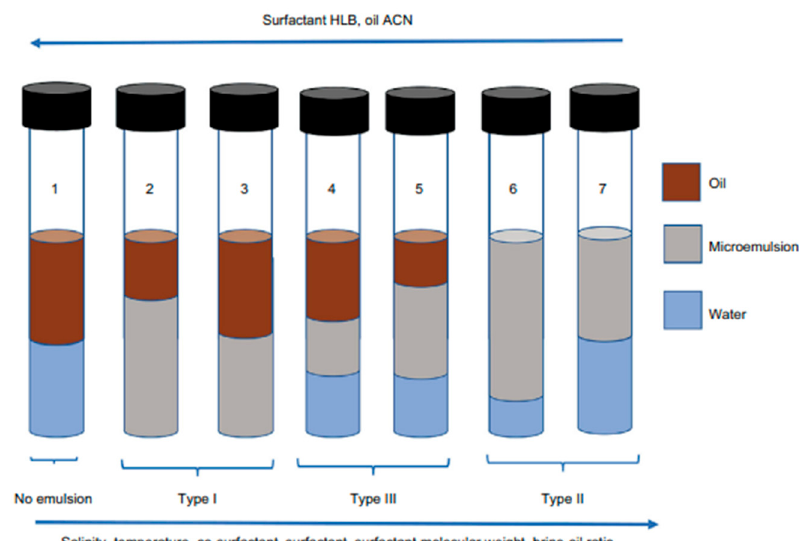
Figure 3. Winsor types